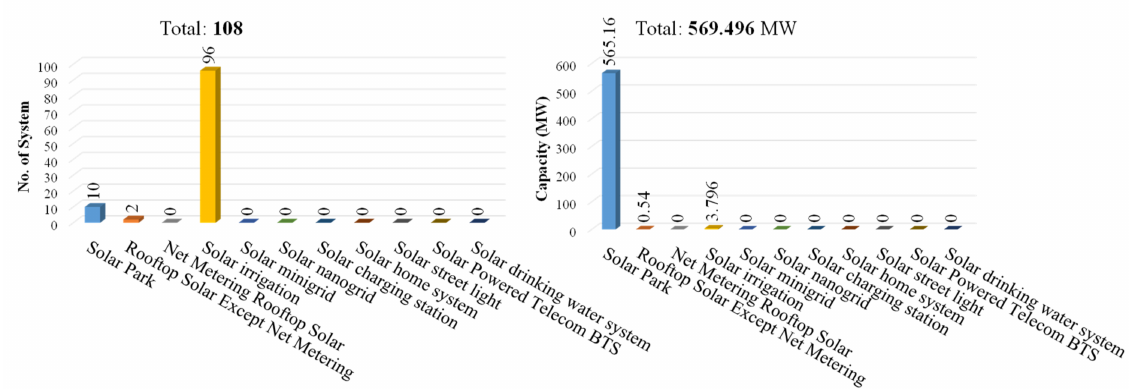
Figure 8. Solar project completed and running, number of systems, and capacity (authors’ creation based on SREDA data [24]).